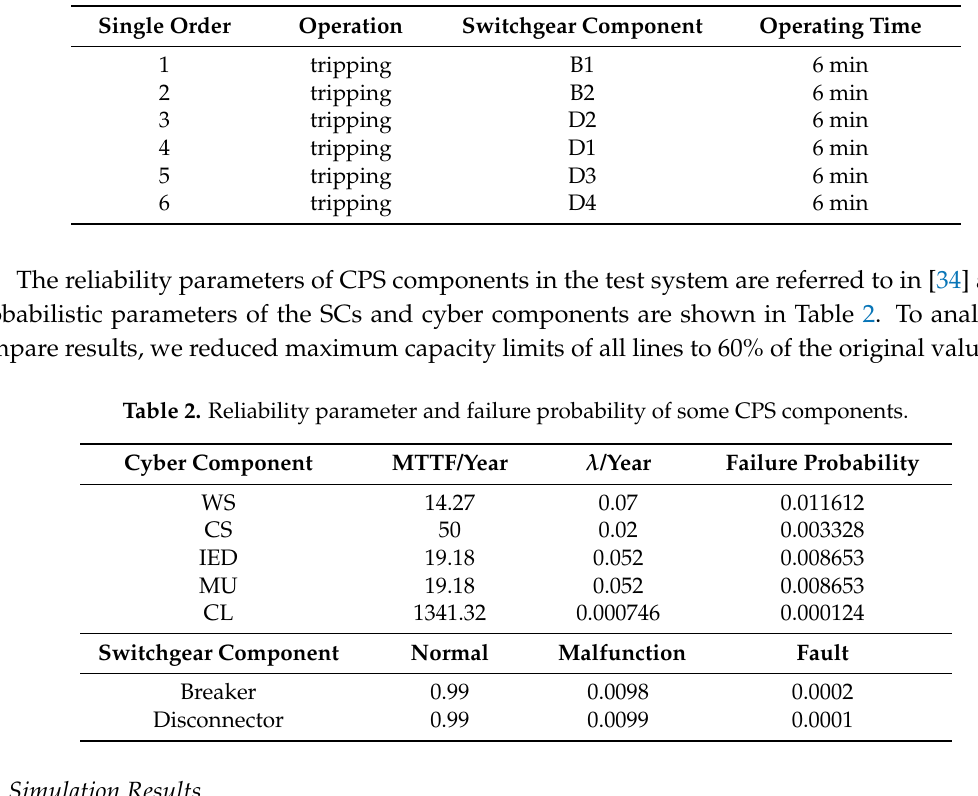
Table 2. Reliability parameter and failure probability of some CPS components.